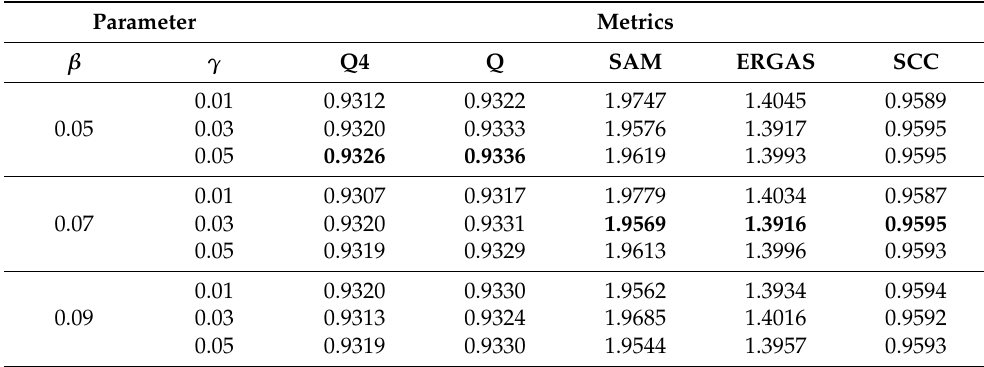
Table 5. Average Quantitative Metrics of Different Regularization Parameters in β L spatial and γ L spectral . The Best Results are Shown in Bold .